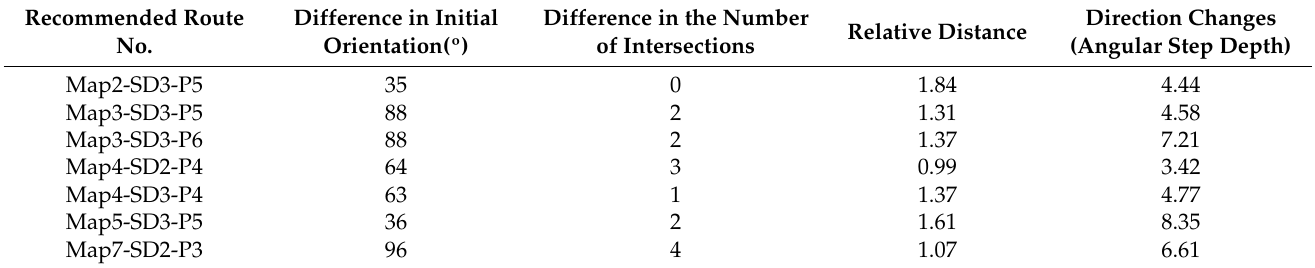
Table 2. Geometric characteristics of seven recommended routes without a significant increase in the choice